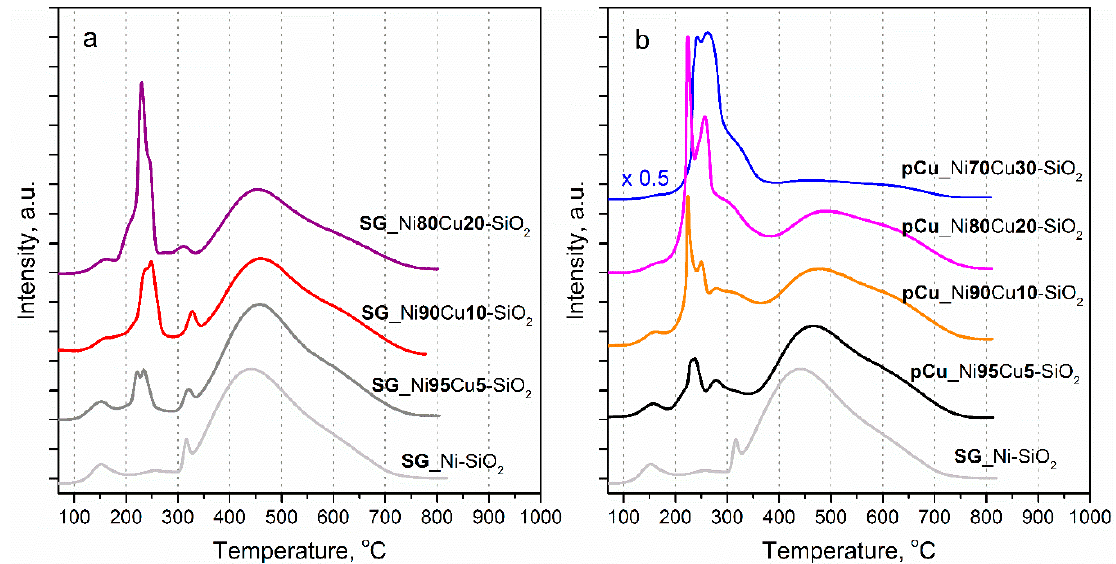
Figure 2. Temperature-programmed reduction (TPR) profiles of the SG ( a ) and pCu ( b ) series of catalysts with different Ni:Cu ratios. Conditions: m cat = 50 mg, 10 vol.% H 2 in Ar, V T = 6°/min.